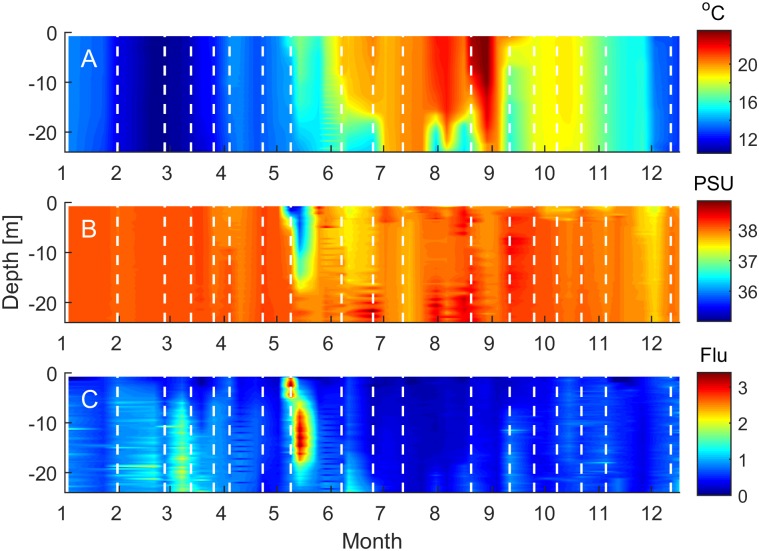
Depth profiles of environmental conditions.Full depth profiles of (A) temperature, (B) salinity and (C) fluorescence were measured at station SOLA in 2012. White dashed lines mark the dates when discrete samples were taken from the surface (3 m) to carry out phosphorous bioassay experiments (Solid black squares in Figs 3 and 4).